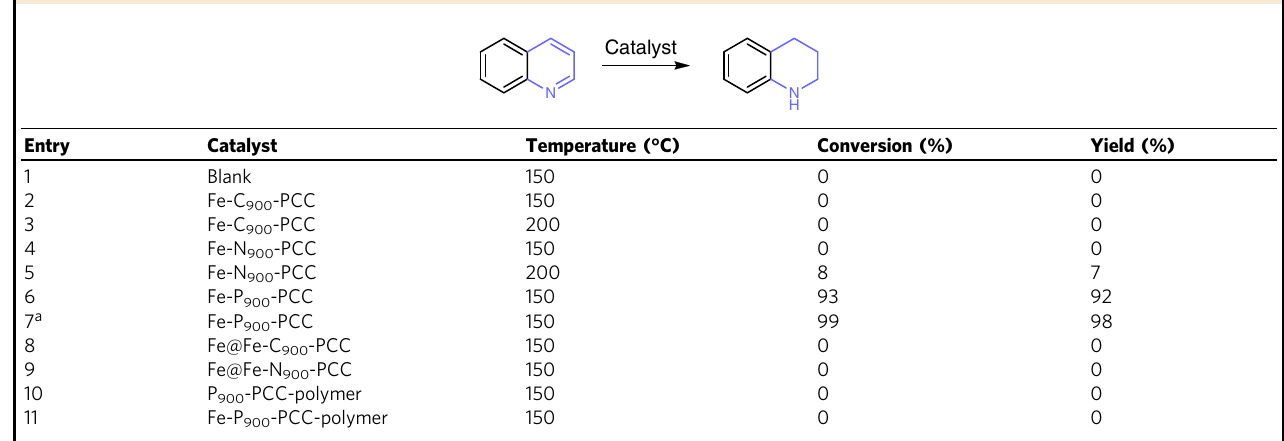
Table 1 Screening of catalysts for the hydrogenation of quinoline to tetrahydroquinoline.